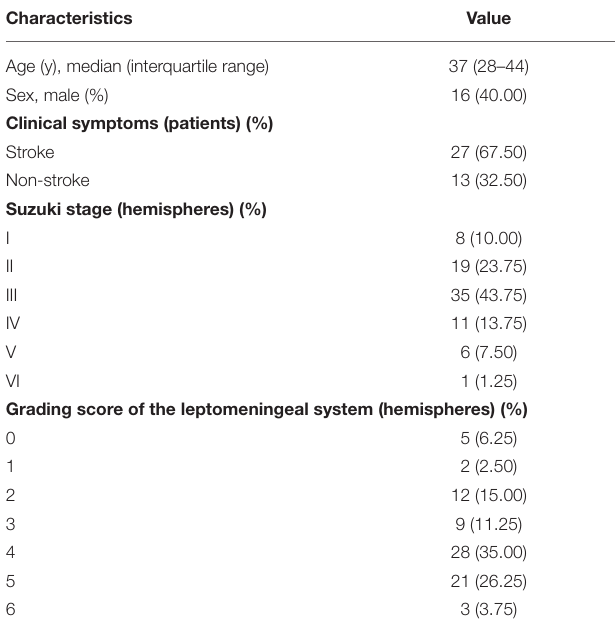
TABLE 1 | Baseline characteristics of eligible